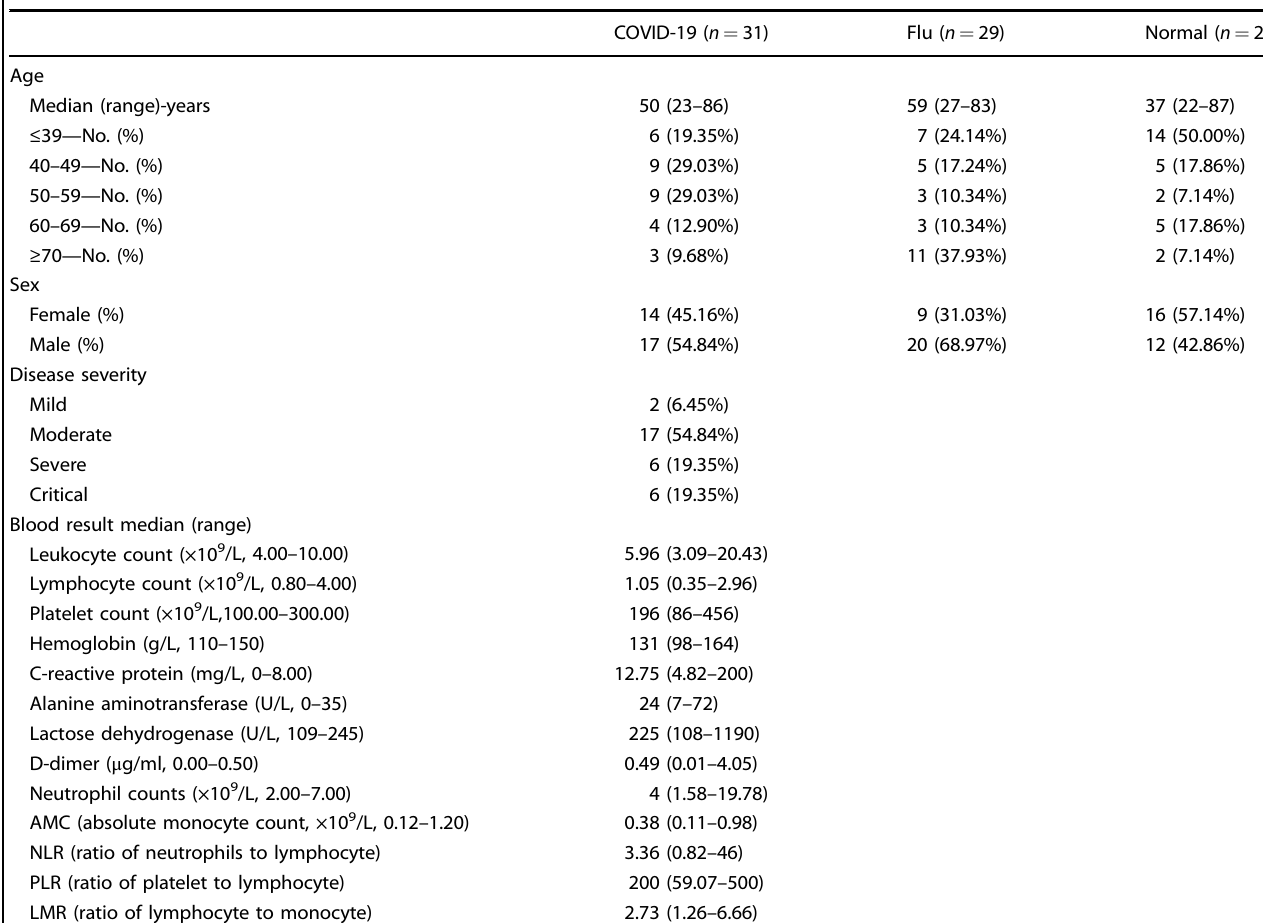
Table 1. Subject